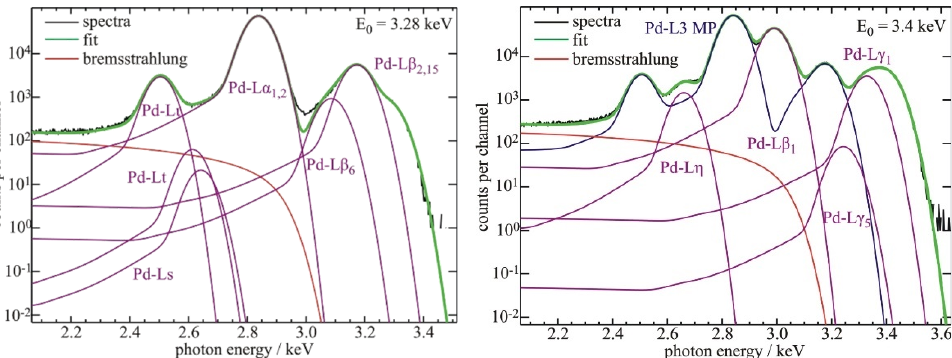
Figure 6. Response-function-based deconvolution of a 250 nm thick Pd layer XRF spectrum for each L-shell used for the experimental determination of Pd-L PCS. To the left, the excitation photon energy of 3.28 keV is chosen to be between the L3 and L2 sub-shell absorption edges and, to the right, the excitation photon energy of 3.4 keV lays between the L2 and L1 absorption edges. MP designates the L3 fluorescence line multiplet used as an ensemble in the L2-related spectral deconvolution. For reference-free XRF in the soft X-ray range, the uncertainties of FP associated